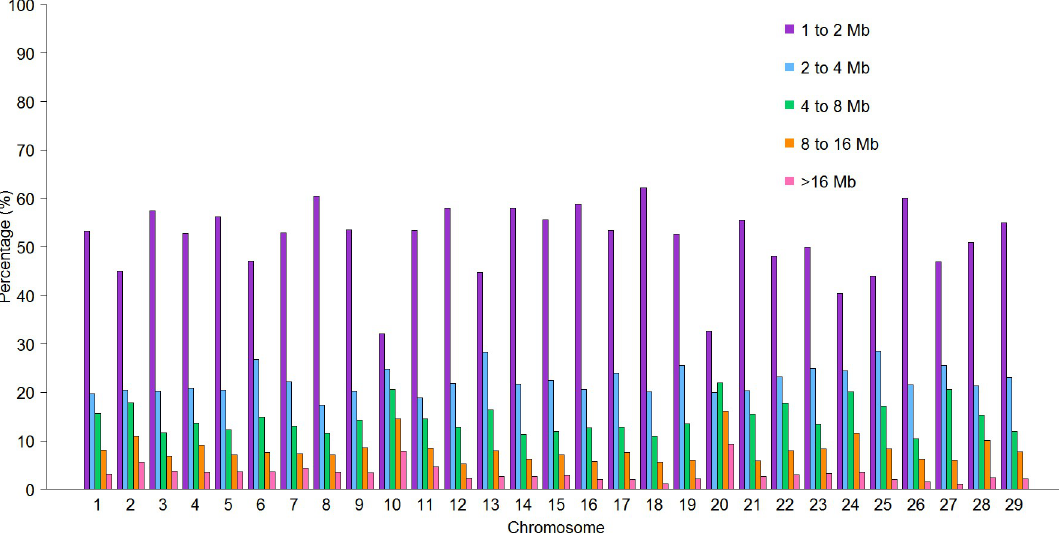
Fig 2. Proportion of ROH, classified by length in each chromosome.